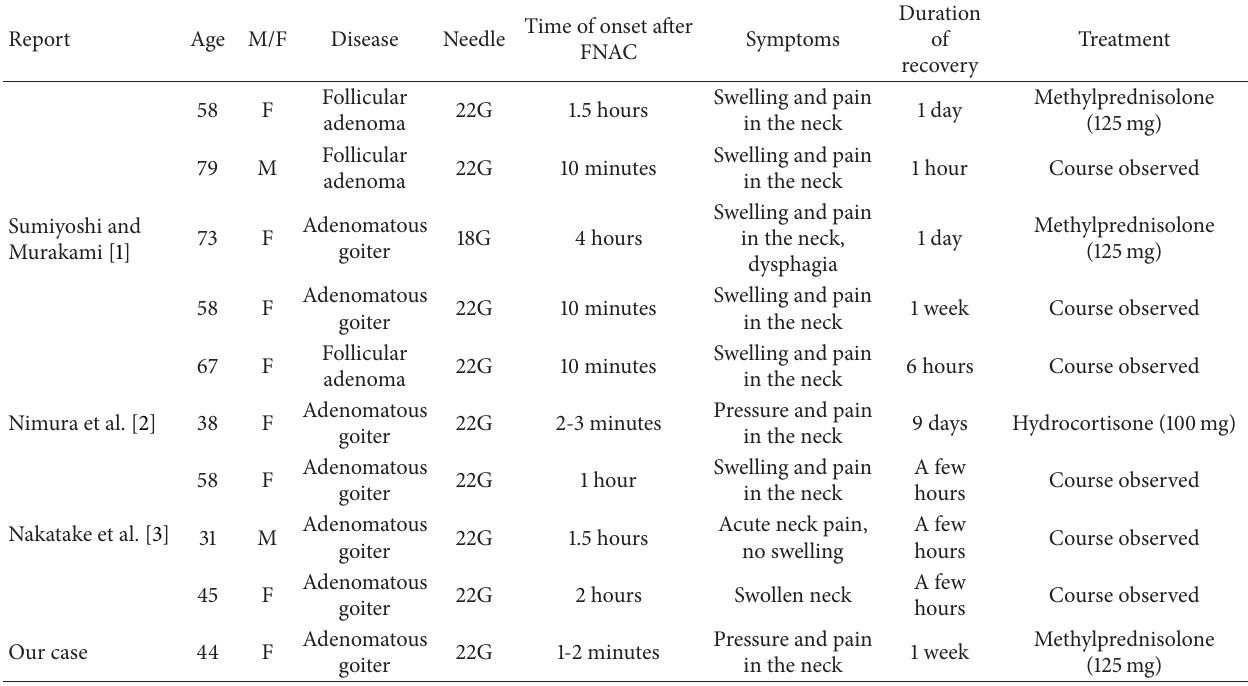
Table 1: The 10 cases of post-FNAC thyroid enlargement reported in Japan (including